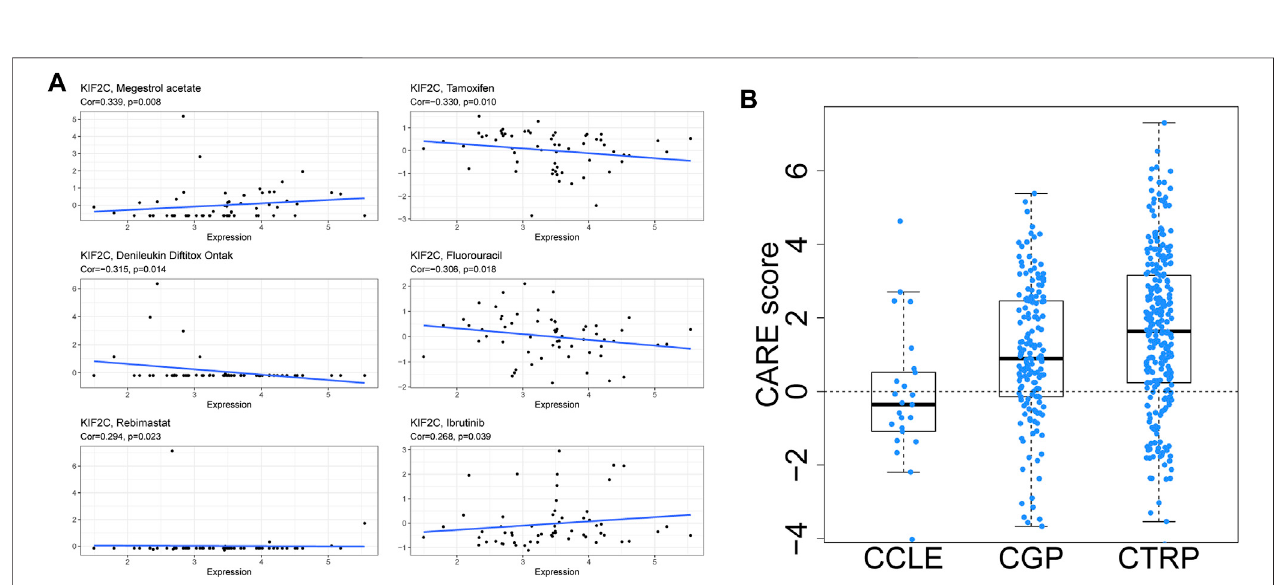
FIGURE 12 | Anticancer drug sensitivity analysis of KIF2C. (A) CellMiner ’ s drug sensitivity analysis. (B) CARE analysis